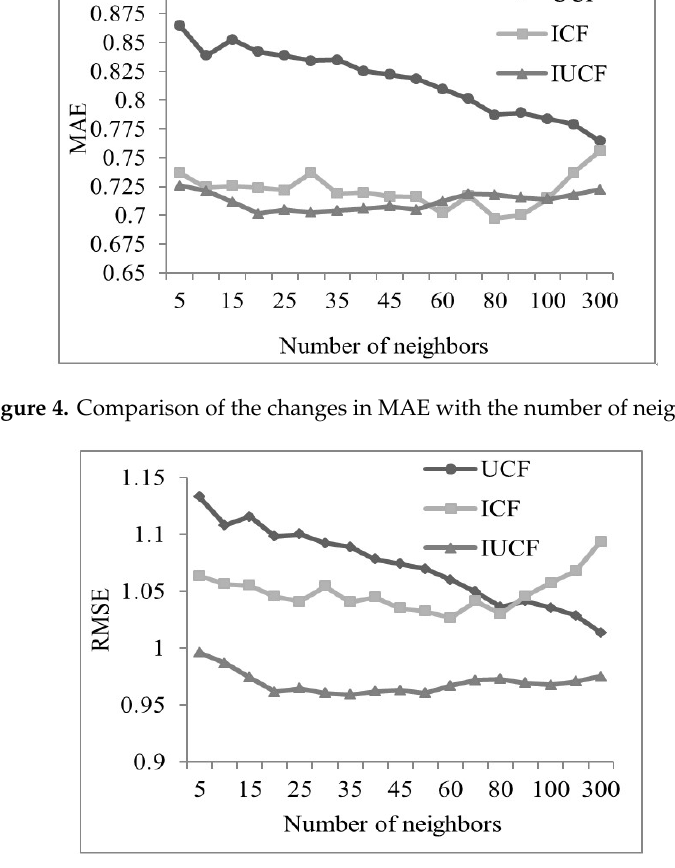
Figure 5. Comparison of changes in RASE with the number of neighbors.